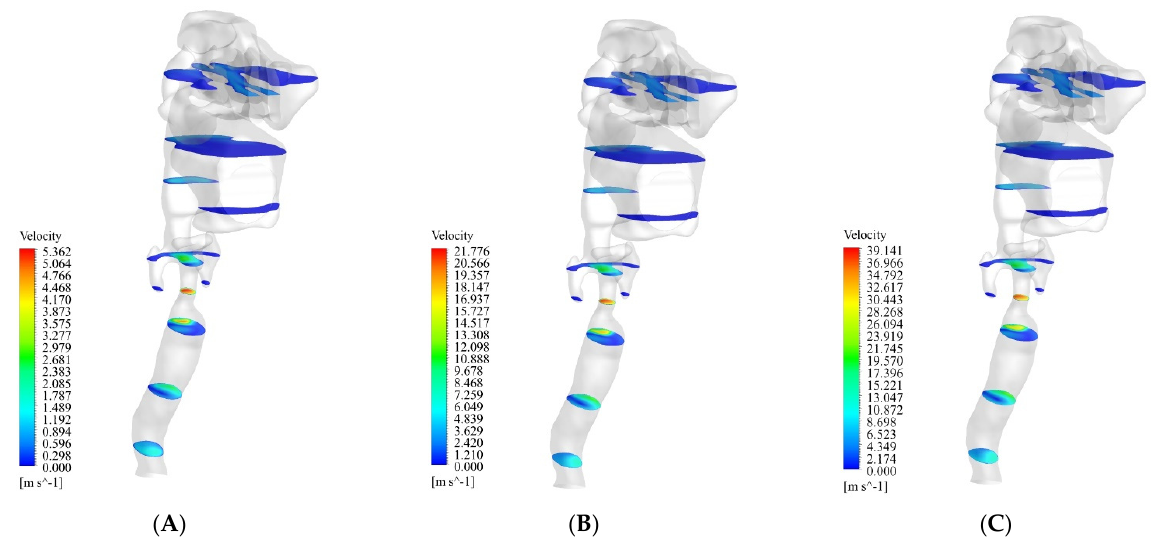
Figure 7. Cross-sectional velocity distribution of the airflow at three flow rates of 13 L/min, 55 L/min, and 100 L/min. ( A ) 13 L/min. ( B ) 55 L/min. ( C ) 100